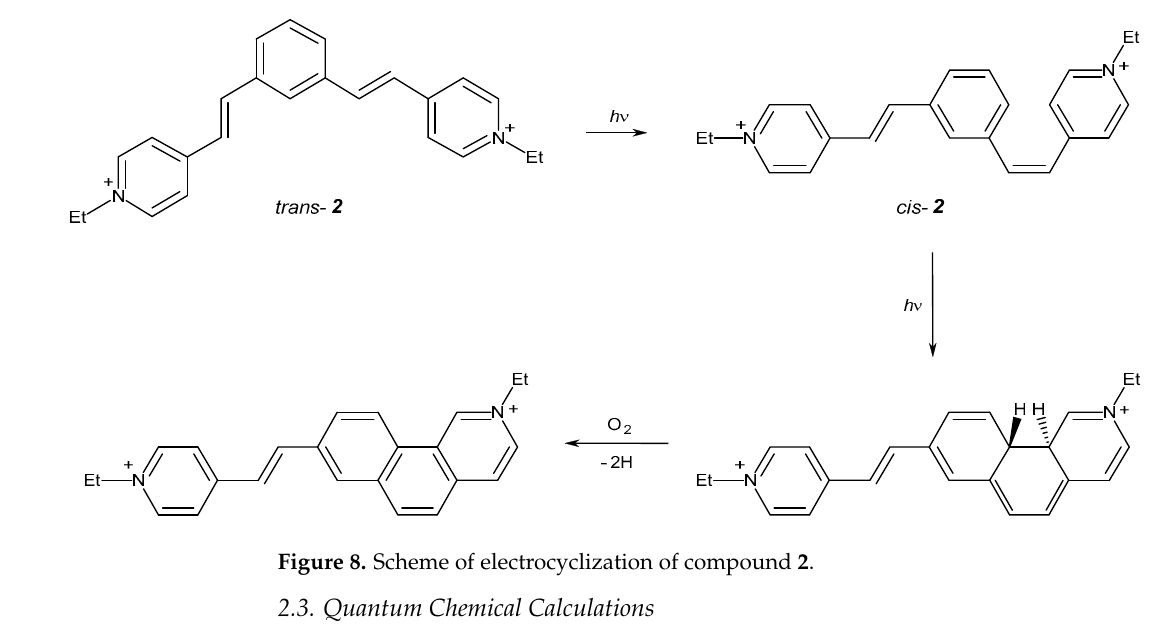
Figure 8. Scheme of electrocyclization of compound 2 .